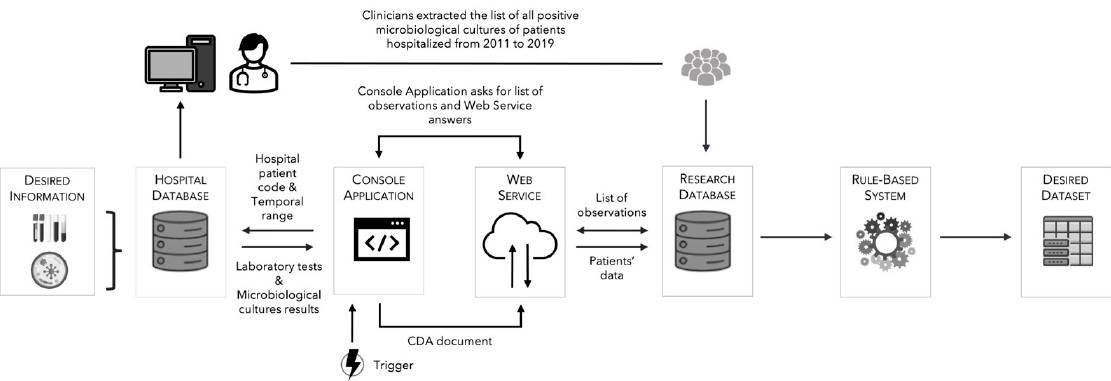
Figure 1. Architecture of the automated extraction system. Legend: Graphical representation of the architecture and sequence of events that lead to the creation of the desired dataset. The events chain that leads the desired information from the hospital LIS towards the research database is regulated by a trigger. The trigger was executed once each night until the data collection phase was completed. Specifically, the console application obtained by the web services the list of episodes, each of them linked to a specific patient and a time span. For each episode, a query is executed in the ad-hoc view of the hospital database in order to read laboratory tests and microbiological culture results. These data are then transferred and stored into the research database. Last, a rule-based system extracts the desired features from the research database and organizes them into the final dataset.